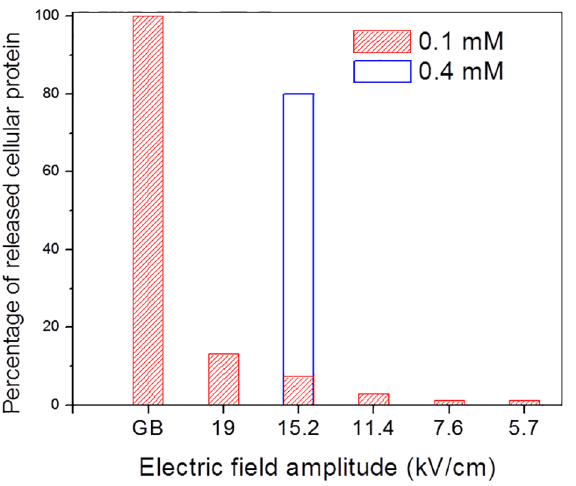
Figure 10. The lysis efficiency of E.coli as a function of electric field strength. The electrical lysis efficiency of E. coli cells for the cases presented in Figure 9 was determined by measuring the released protein as compared to glass bead beating. Only the case which involved flash heating gave comparable results indicating the synergy of electric field and heat lysis mechanisms.